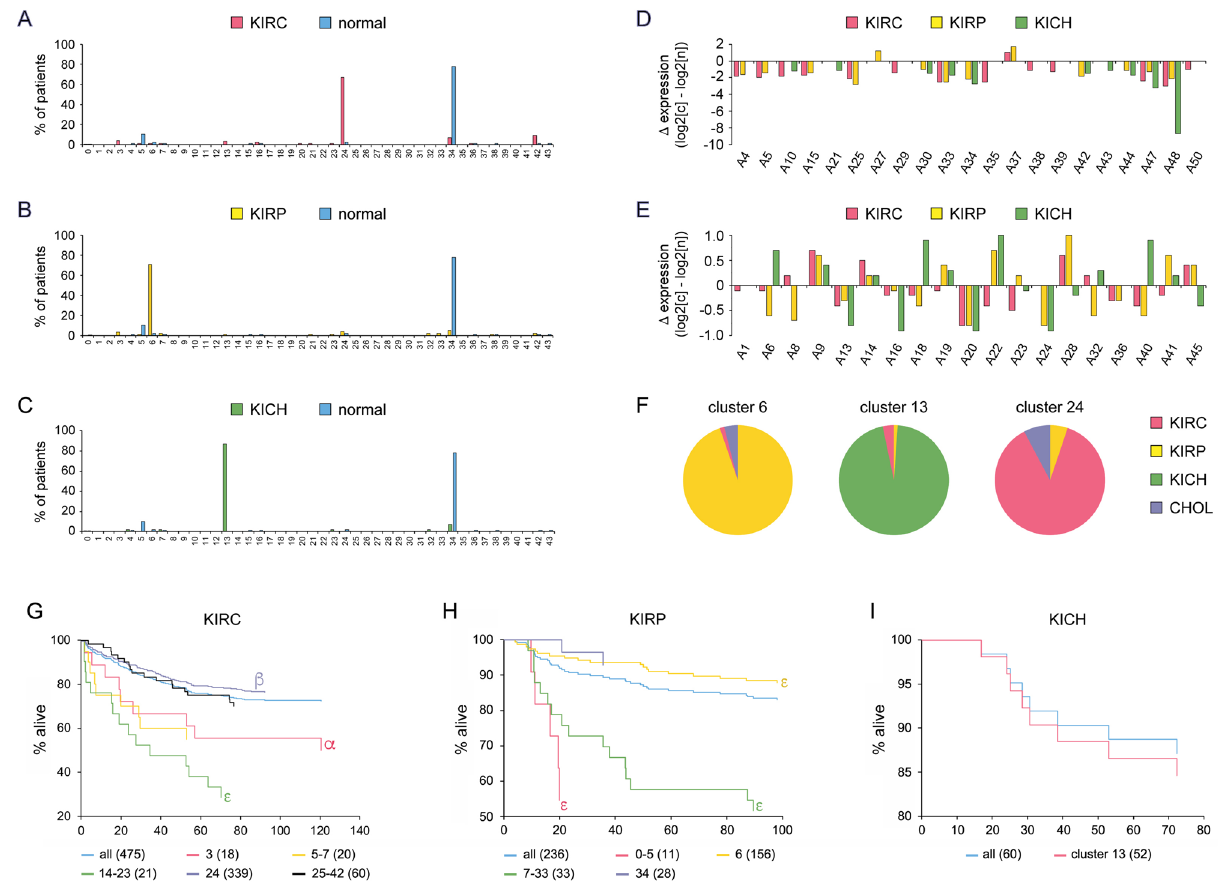
Figure 3. SLC25 gene expression in the three major kidney cancers. KIRC (n = 475), KIRP (n = 236), KICH (60), and normal kidney (n = 138). ( A – C ) Distribution of cancer and normal patients in SLC25 expression clusters. ( D ) Expression of L26-S24 genes ≥ twofold or ( E ) less than < twofold larger in KIRC (cluster 24), KIRP (clusters 6), and KICH (cluster 13) cancers (c) compared to normal (n) tissue (cluster 34). Expression is median of the ratio of tumor (Supplementary Fig. S9) and normal (Supplementary Fig. S10) box plot. ( F ) Pie charts for the principal kidney tumor expression clusters. ( G – I ) Kaplan–Meier plots. ‘all’ is total population of cancer type. The number of patients is noted in parentheses. Statistical analyses compared survival of patients of a single cluster or defined group of clusters to the total patient cancer type population. α = p < 0.05; β = p < 0.025; γ = p < 0.02; δ = p < 0.01; ε = p <